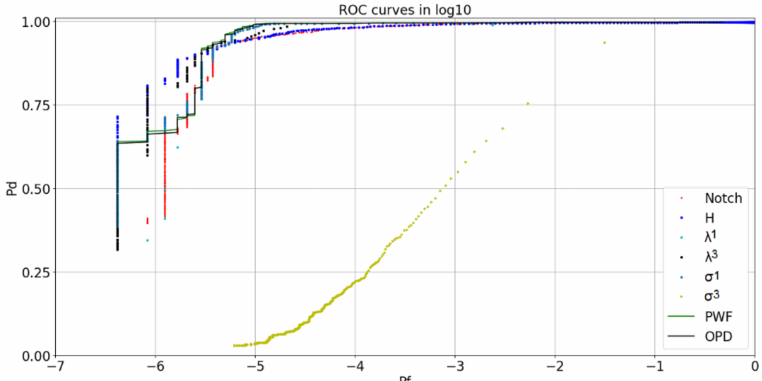
Figure 11. Iceberg detection ROC curves for open ocean, target size 5 × 5, clutter size 105 × 105. Notch means the polarimetric notch filter, H means entropy, λ 1 and λ 3 are the first and third eigenvalues of the covariance matrix, σ 1 and σ 3 are from the polarimetric match filter, PWF means the polarimetric whitening filter, and OPD means the optimal polarimetric